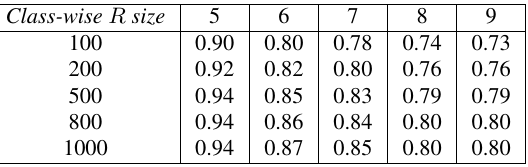
Table 1: Experiment A accuracy results for each new class 5-9. Class R size: number of training points selected per class.